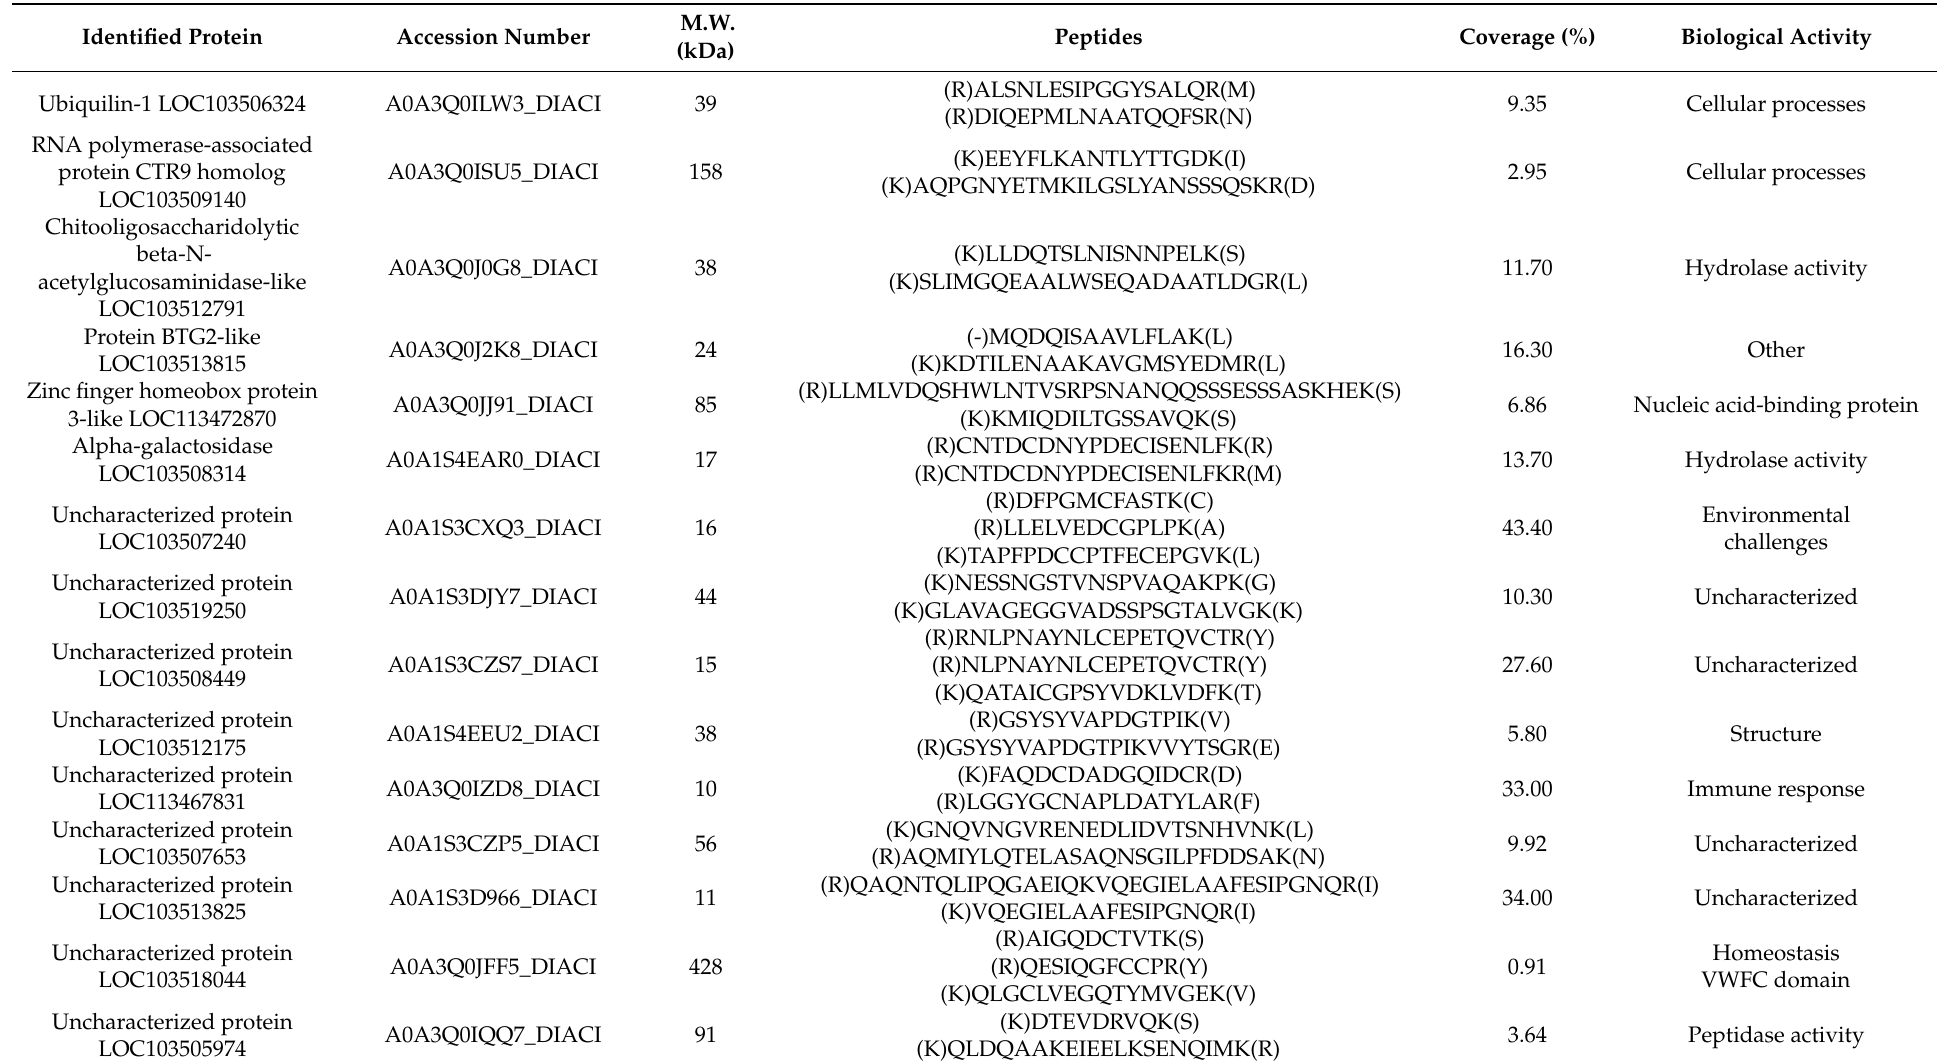
Table 1. Proteins identified from Diaphorina citri